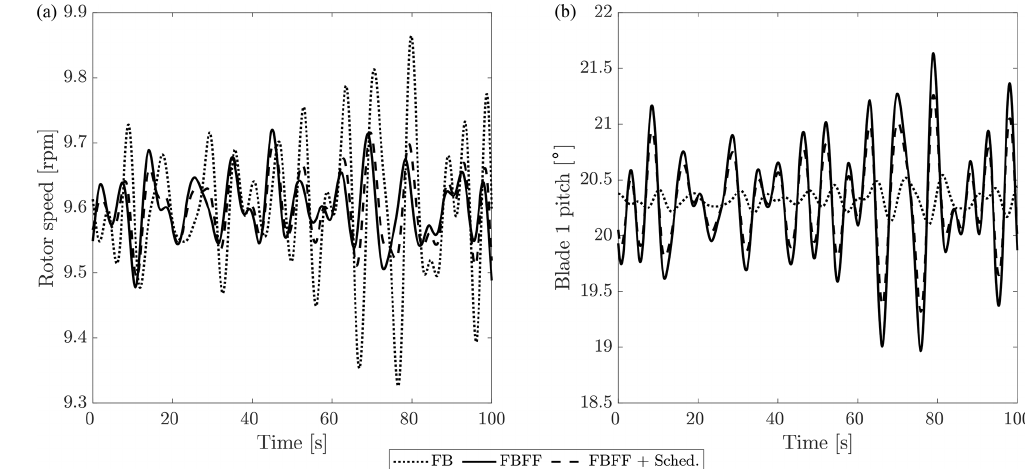
Figure 12. Time series of the rotor speed (a) and blade-1 pitch angle command (b) for the 22m/s steady wind case.